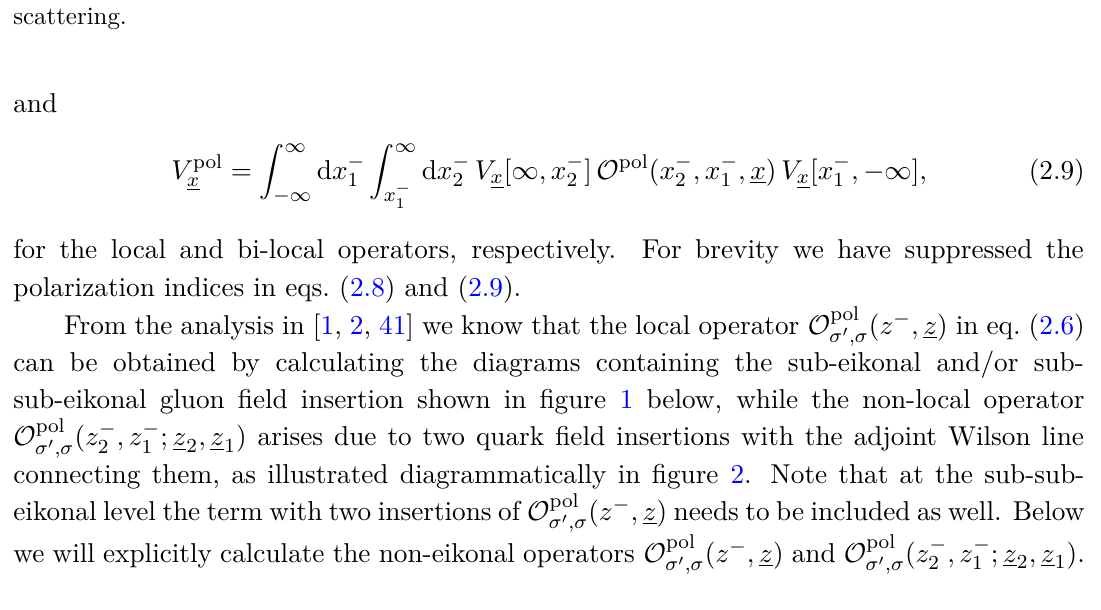
Figure 1. The diagram representing the gluon field contribution to the non-eikonal operator. The black circles on the vertices designate potentially spin-dependent sub- and sub-sub-eikonal